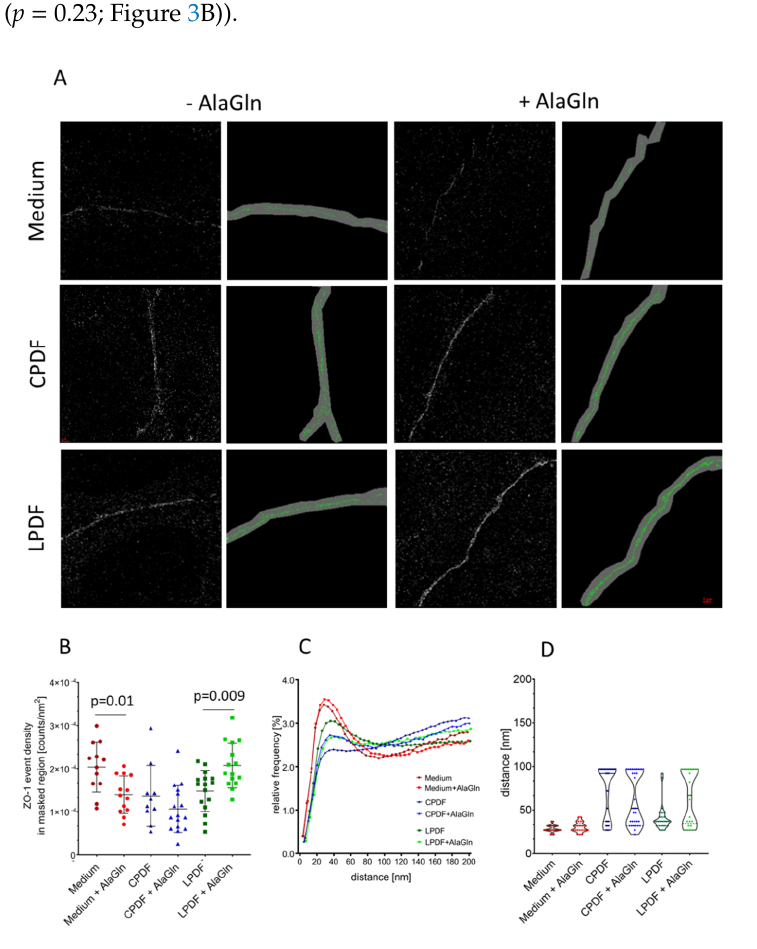
Figure 3. Single molecule localization microscopy was used for quantification of positioning and clustering of single ZO-1 molecules at the junction area of HUVEC, cultured on transwell filters. Representative localization images reconstructed from the loci data matrix are given in ( A ) with and without masking, mask width is 100 nm (scale bar = 1µm). ( B ) ZO-1 molecule density for given treatments, ( C ) Ripley frequency distance curves: relative frequencies of point-to-point distances given on the x-axis ( D ) respective violin plots of the distances at which most molecules were found. Alanyl-glutamine (AlaGln) reduced the number of fluorophore signals in the membrane of endothelial cell incubated with medium and increased it with LPDF incubation ( B ). ZO-1 molecule clustering was changed in a characteristic way when AlaGln was added ( C , D ).